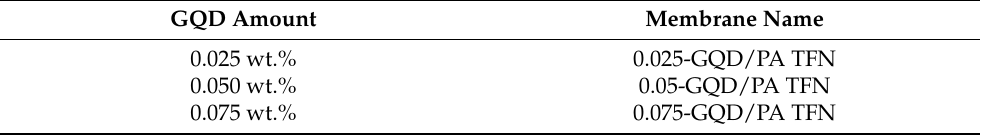
Table 1. Naming of the different developed